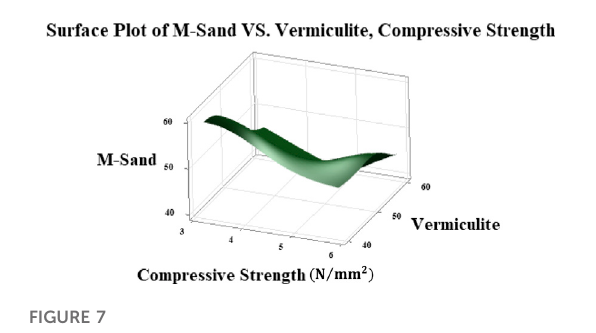
FIGURE 7 Surface plot for compressive strength.